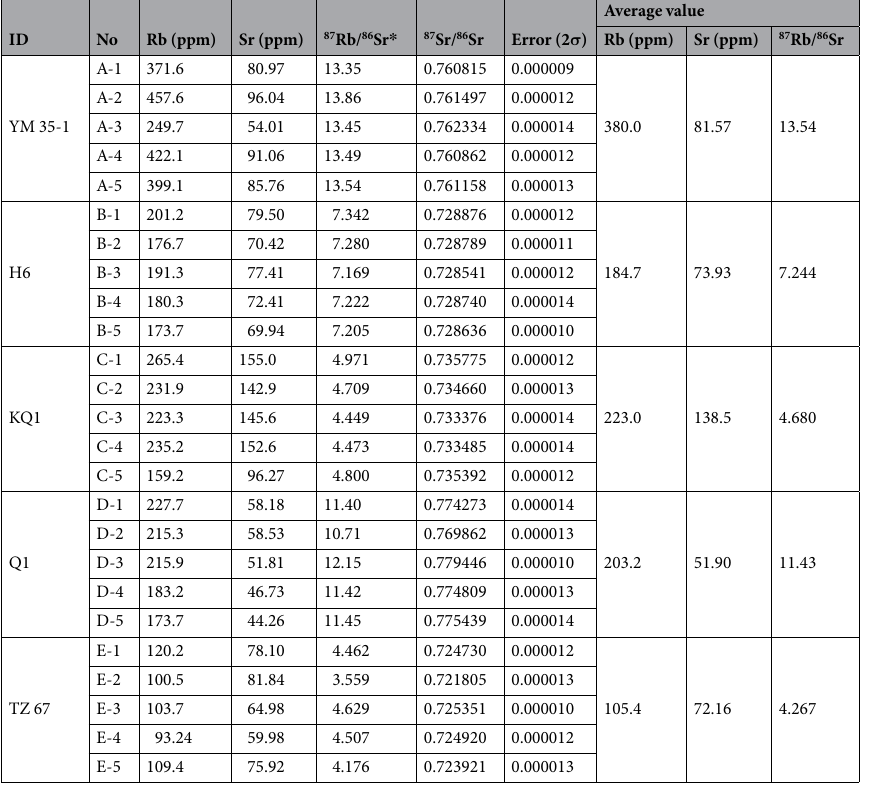
Table 2. Rubidium-Strontium isotope data for illitic clays in this study of the Tarim Basin. * Error for 87 Rb/ 86 Sr ratio is 1% (2 σ